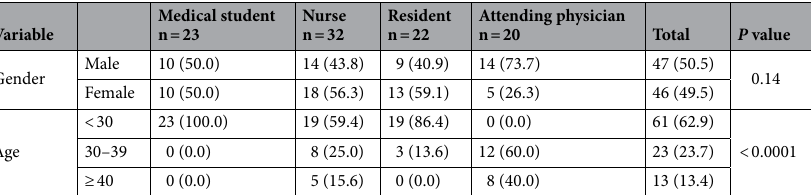
Table 1. Demographic characteristics of the target population stratified by HCP category a, b . a Cell counts may not add up to the raw total due to missing responses in the data. b Valid percentages were used.